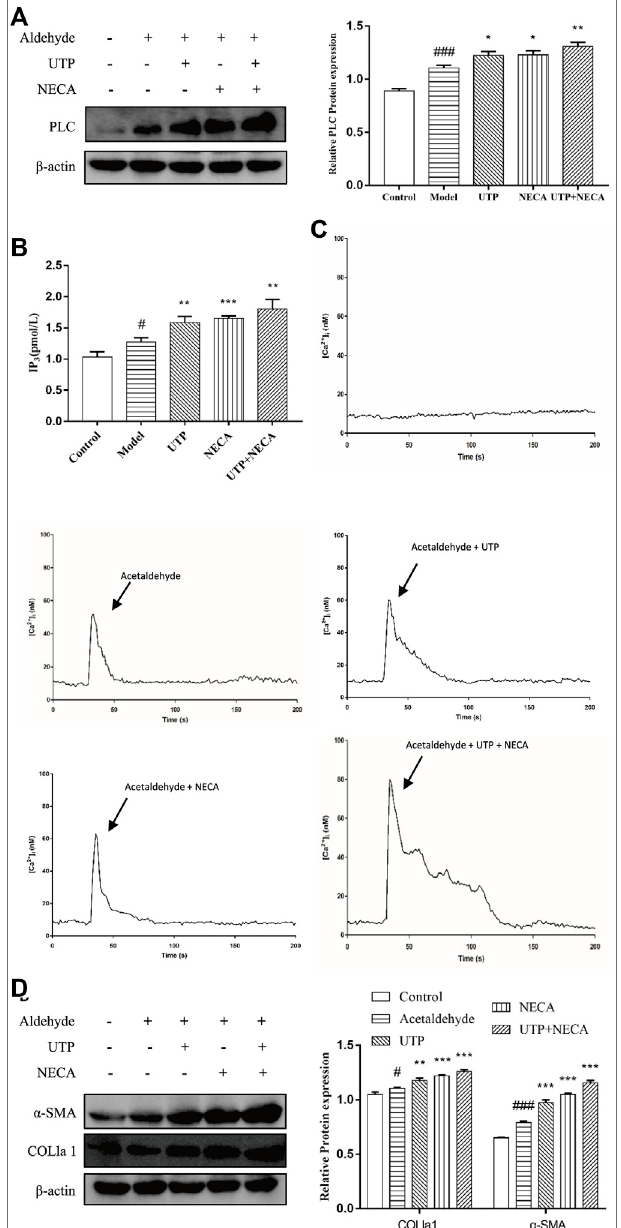
FIGURE10| EffectofthePLC-IP 3 -Ca 2+ /DAG-PKCsignalingpathwayin acetaldehyde-induced HSC-T6 cell. (A) The protein levels of PLC in HSC-T6 cell. (B) The content of IP 3 was assessed by ELISA. (C) [Ca 2+ ] i concentration changes as visualized by Fluo-3-AM. (D) The protein levels of α -SMA and COL1a1 in HSC-T6 cell. # p < 0.05, ### p < 0.001 vs. the control group, *p < 0.05, **p < 0.01, ***p < 0.001 vs. the model